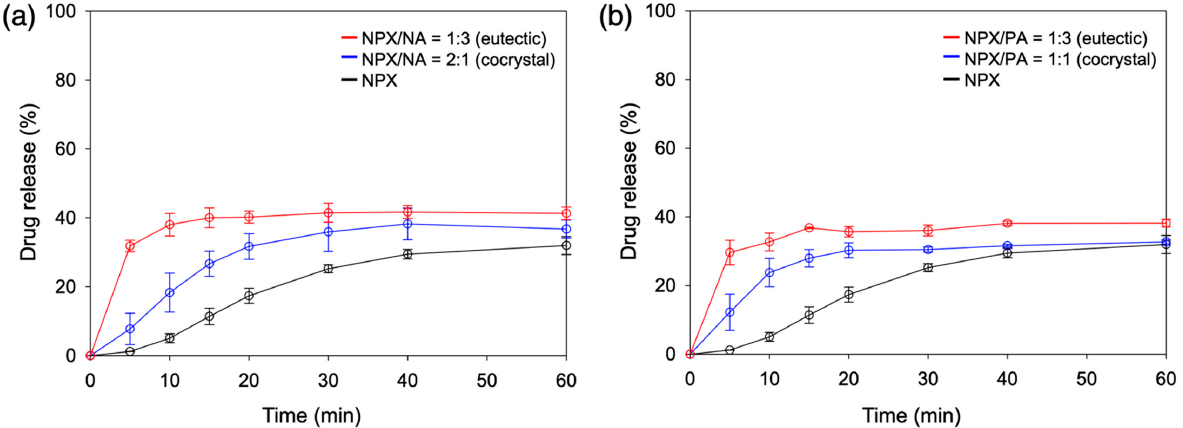
Figure 5. Dissolution profiles (pH 5.0, 60 min, n = 3) of ( a ) NPX/NA and ( b ) NPX/PA. Eutectics and cocrystals are compared with neat NPX.